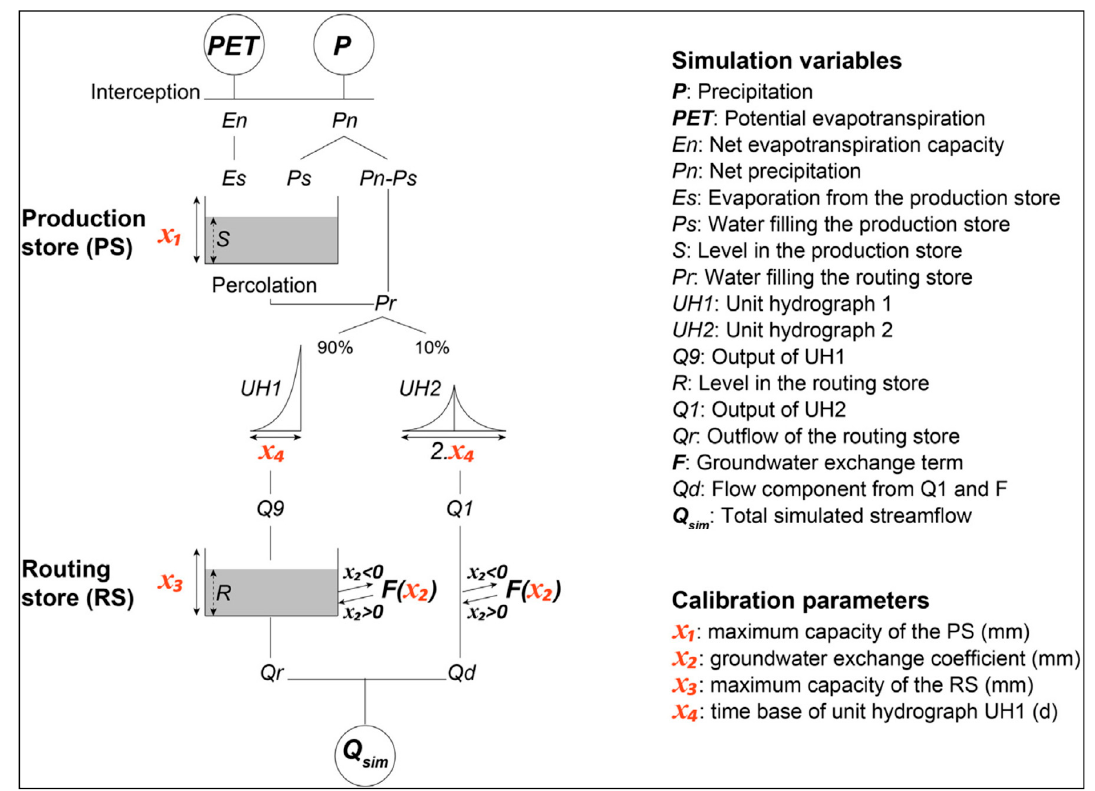
Figure 2. Conceptual scheme of the GR4J model [22].